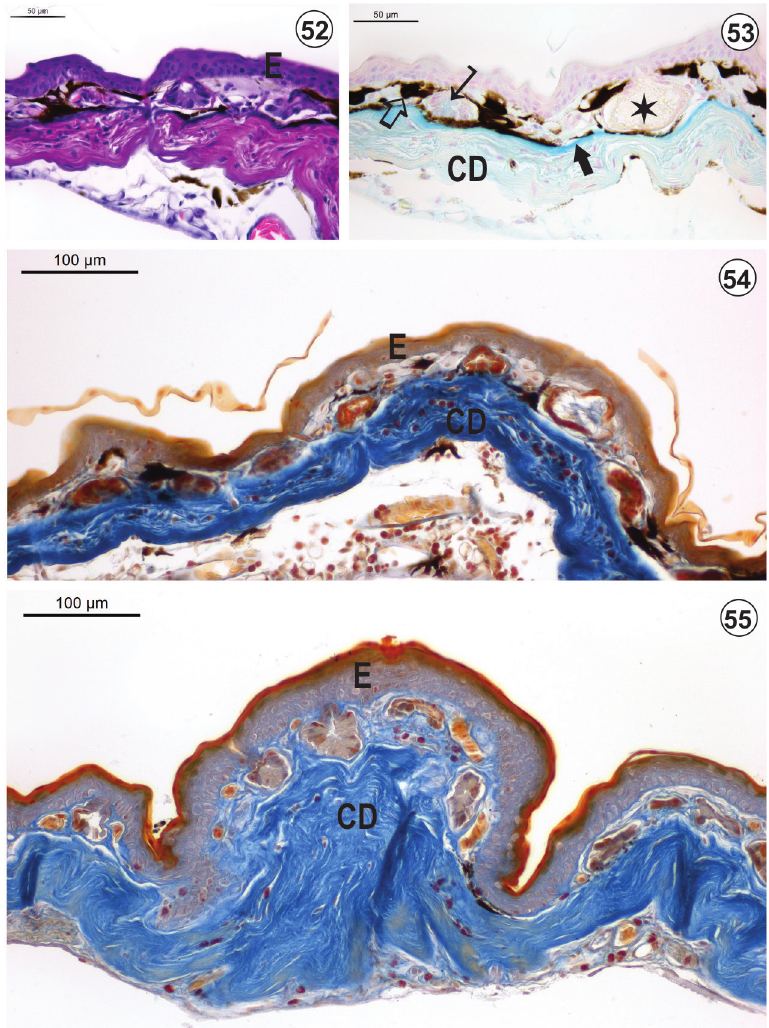
Figures 52–55. Light micrograph of the integument of S. x-signatus : (52) Dorsal region (HE-staining); (53) Dorsal region (AB-method); (54) Ventrolateral region (Mallory´s trichrome staining); (55) Ventral region (Mallory´s trichrome staining). The epidermis (E) is slightly ticker when compared to those of other hylids, as in the compact dermis (CD). Melanophores ( _ ) are visulized in both dorsal and ventrolateral integument just beneath the epidermis. Serous glands are present in all regions; however, some of them show slightly alcianophilic con- tent ( → ) in both ventrolateral and ventral regions. The apocrine glands ( ¬ ) with granular content occur in both dorsal and ventrolateral regions. The EK-layer ( Æ ) is visualized in both dorsal and ventrolateral integument but is absent in the ventral